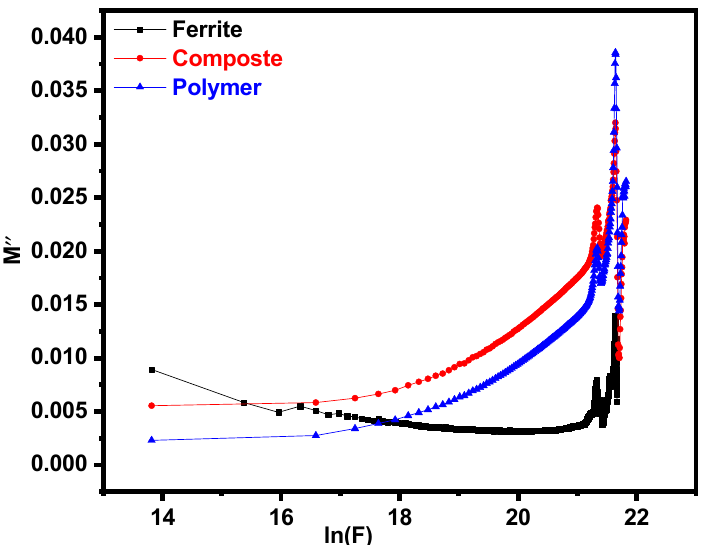
Figure 9. Variation in imaginary parts of electric modulus with the frequency of Y-type hexaferrite Sr 2 Co 2 Fe 12 O 22 , composite (Sr 2 Co 2 Fe 12 O 22 + PPy-DBSA) and polymer PPy-DBSA.